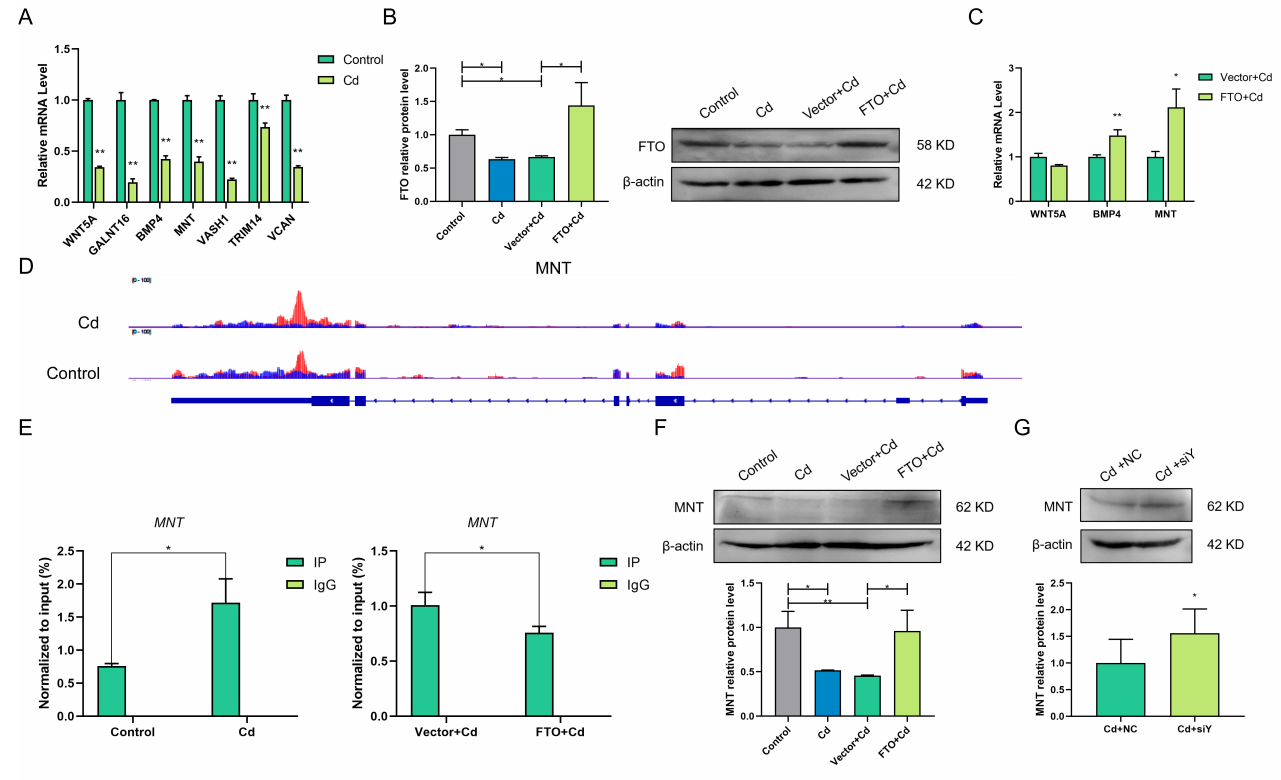
Figure 5. FTO affects m 6 A modification and the expression level of the MNT mRNA. ( A ) RT- qPCR results revealed the relative expression of seven potential target genes in the control and Cd groups. ( B ) Determination of FTO expression level after transfection with pcDNA3.1-FTO or pcDNA3.1-Vector. ( C ) RT-qPCR results revealed the mRNA expression of target genes after FTO overexpression. ( D ) Distribution of m 6 A peaks across MNT transcriptome. ( E ) Determination of m 6 A modification level of MNT mRNA after Cd treatment and FTO overexpression using MeRIP-RT-qPCR. ( F ) Western blotting results showed MNT protein expression after Cd treatment and FTO